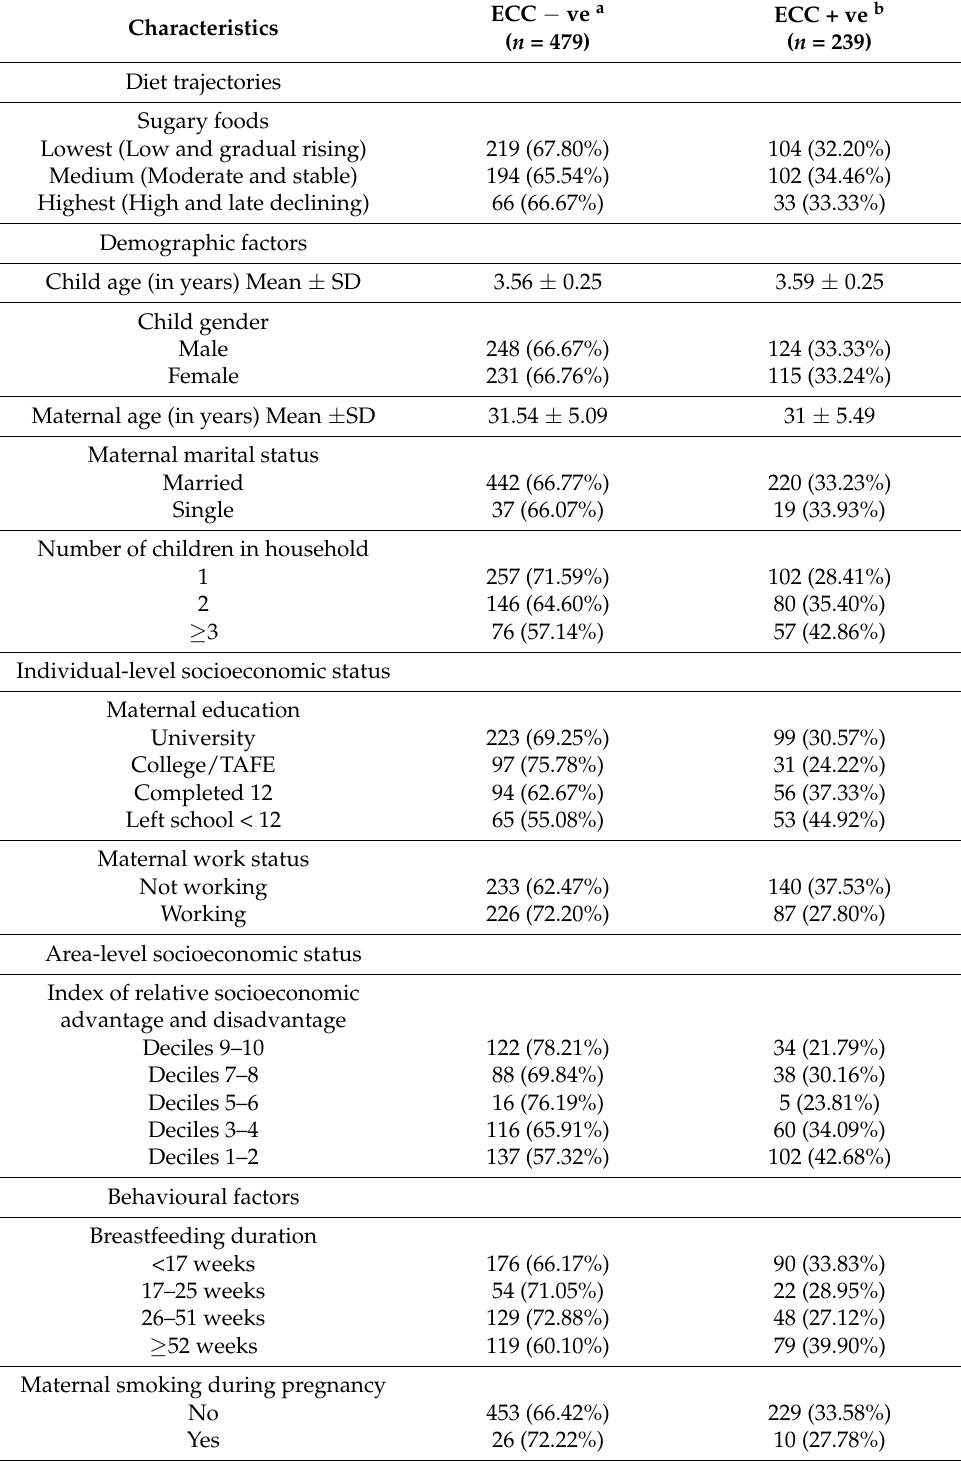
Table 2. Participant characteristics—diet trajectories, demographic, socioeconomic, and behavioural characteristics based on early childhood caries (ECC) groups ( n =